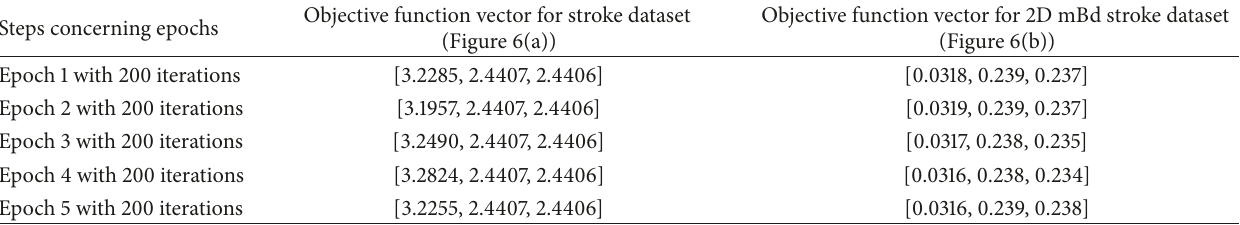
Table 7: Result of FCM algorithm clustering with for 1000 Iterations (as obtained from Figure 6).